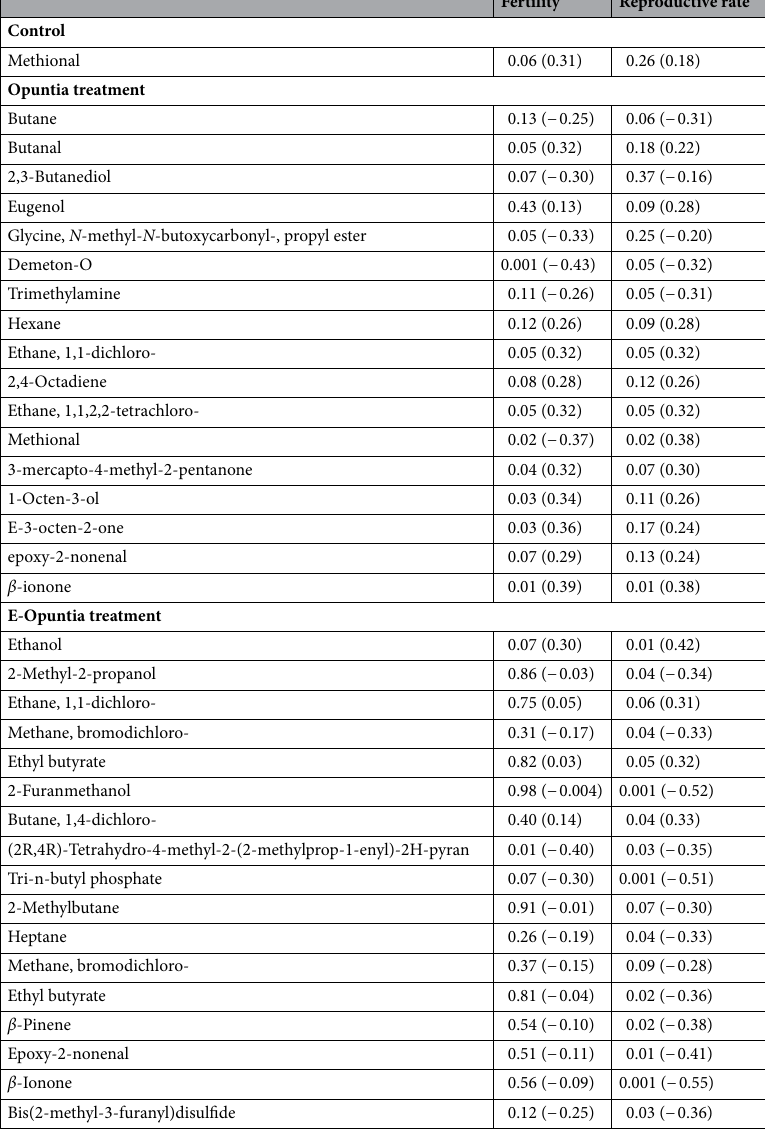
Table 4. Correlationships among urinary metabolomic compounds and fertility (% pregnant per 100 ewes mated) or reproductive rate (% pregnant per 100 ewes exposed to rams), according nutritional treatment: Control (alfalfa only); Opuntia (Opuntia only) or E-Opuntia (protein-enriched opuntia). Values are p value ( r ).